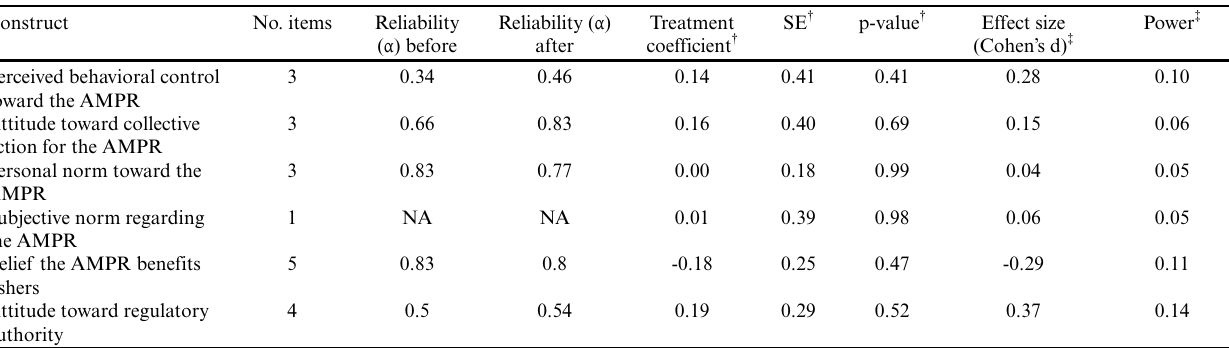
Table 4 . Measured